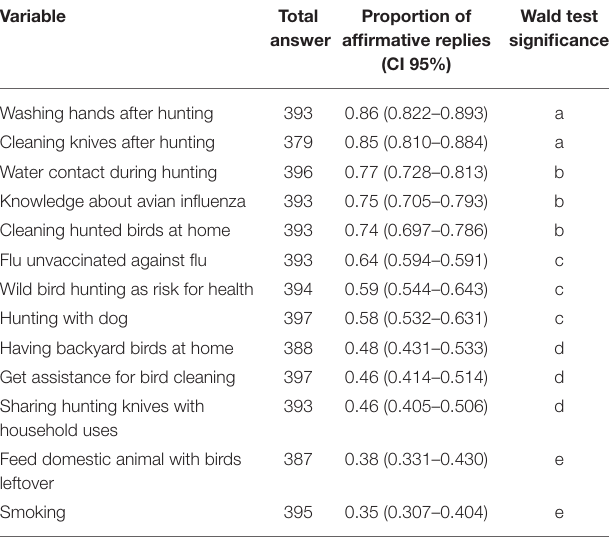
TABLE 3 | Relationship of risk attitudes and knowledge of Cuban hunters on avian influenza virus exposure.